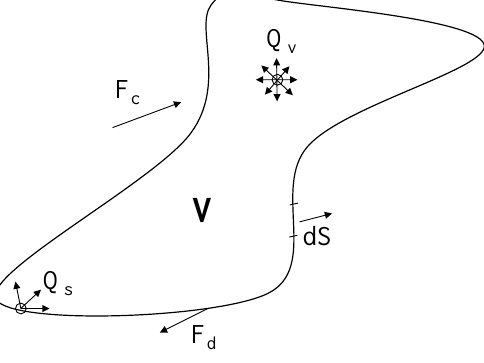
Figure 5. General form of the conservation law.